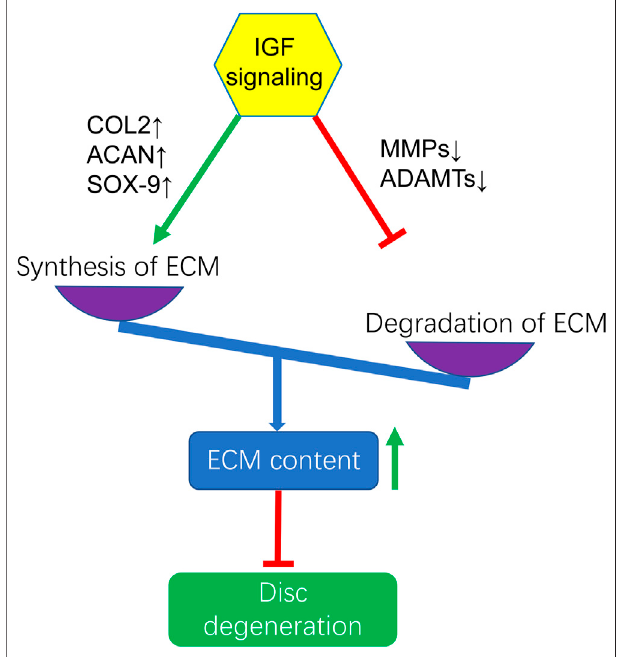
FIGURE 2 | Activation of IGF signaling enhances ECM content by increasing the synthesis of ECM through upregulating the gene expression of COL2, ACAN, SOX-9 and inhibitng the degradation of ECM by downregulating the gene expression of MMPs and ADAMTs to exert protection against IVDD. COL2, Collagen-II; ACAN,